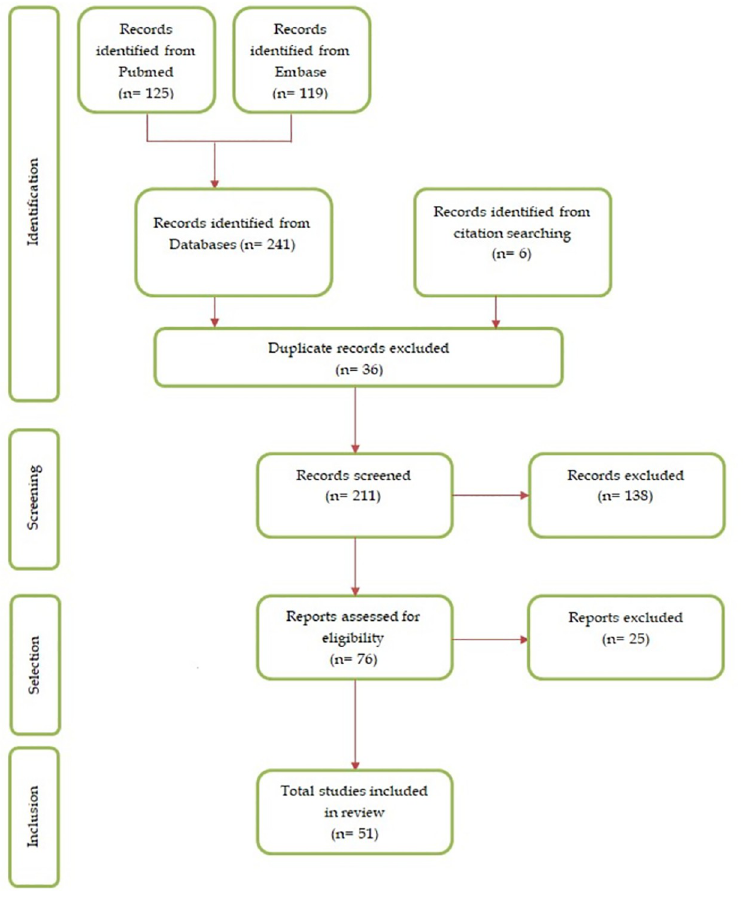
Fig 1. PRISMA 2020 flow diagram for studies selection (search until April